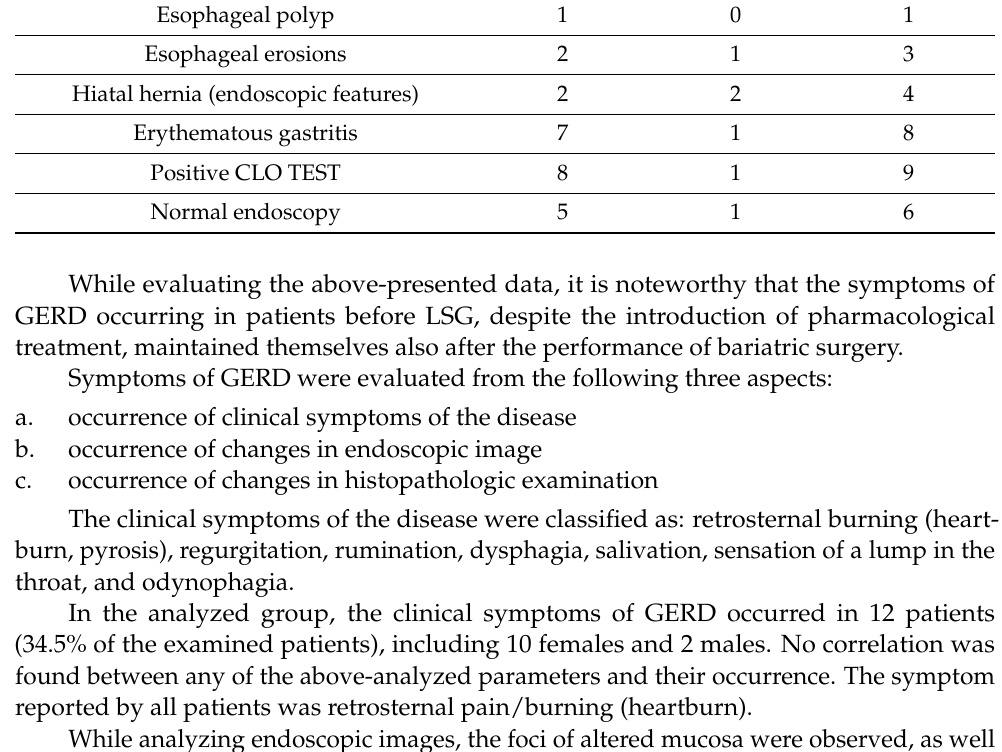
Ischaemic heart disease Table 6. Results of pre-operative endoscopic assessment in the examined group of patients. Females Males